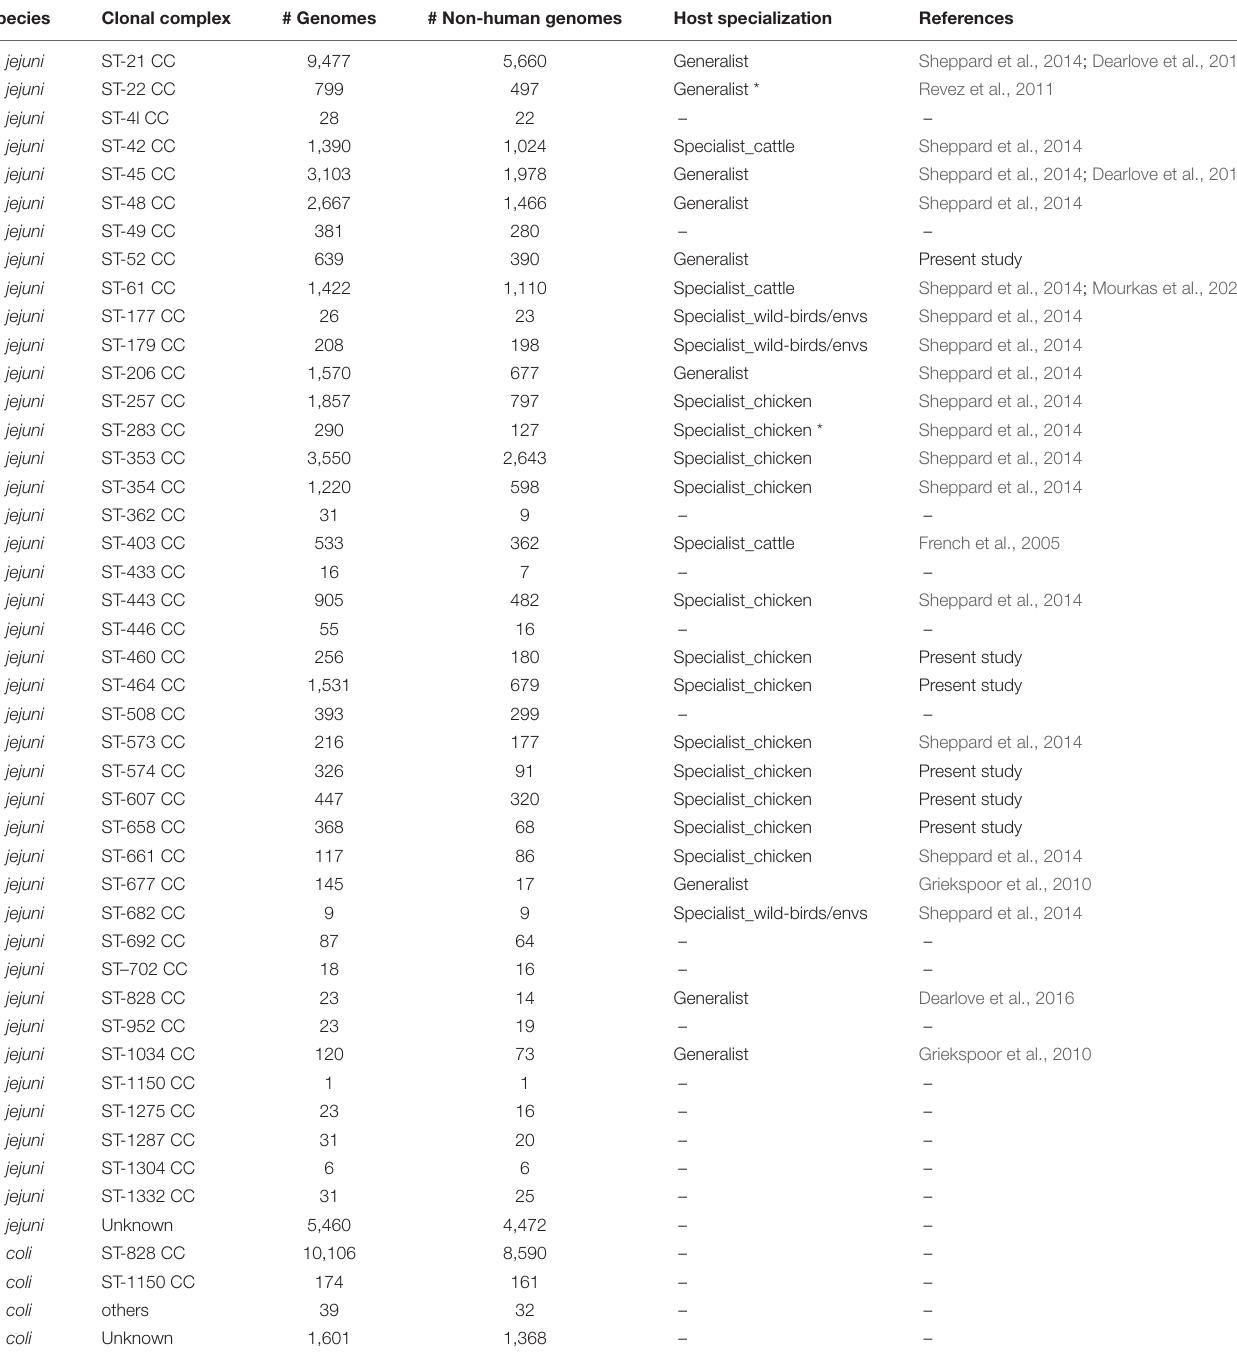
TABLE 2 | Clonal complex classification by their host specialization according to previous publications and to the results of the current study. Species Clonal